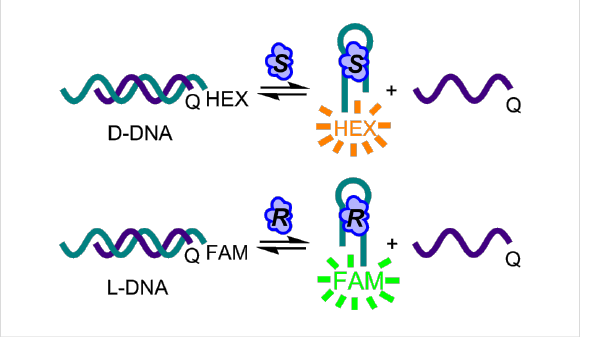
Figure 5: Structure switching biosensors convert the presence of a target into a dose-dependent fluorescence signal, and construction of biosensors from opposite enantiomers of DNA enables rapid measure- ment of enantiopurity using two-color fluorescence. Adapted with permission from [4]. Copyright (2015) American Chemical